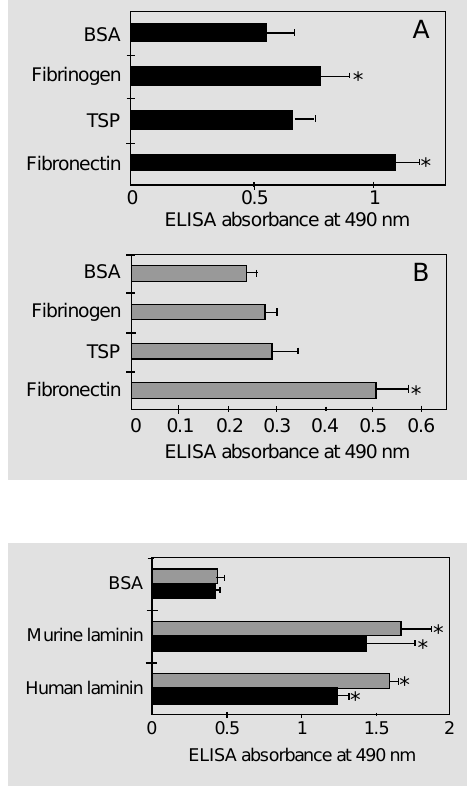
nm0.5 ELISA absorbance at 490